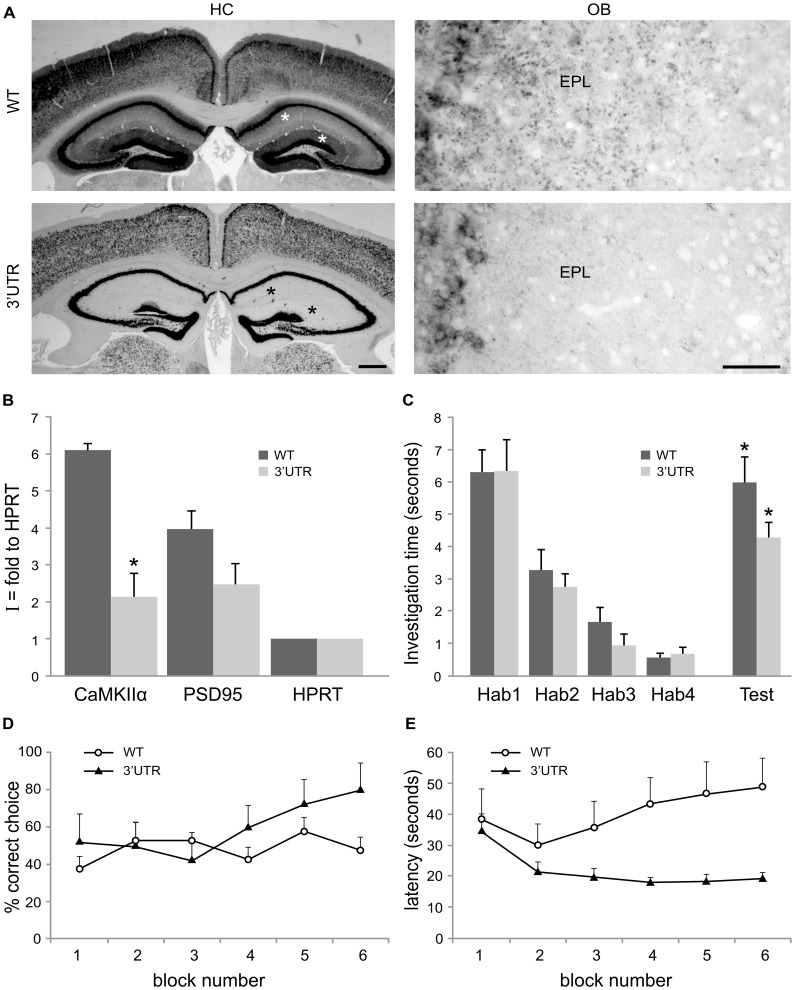
Altered CaMKIIα mRNA and protein synaptic localization disrupts olfactory associative learning.
A,
In situ hybridization for CaMKIIα mRNA in wild-type mice (WT, upper panels) and 3′UTR mutants (3′UTR, lower panels) shows a dramatic decrease of the dendritic staining (stars) in the mutant hippocampus (HC, left panels) and olfactory bulb (OB, right panels). EPL: external plexiform layer Scale bars: 200 µm and 50 µm, in HC and OB respectively. B, Quantification of the index of synaptic localization (I) of CaMKIIα and PSD95 mRNAs normalized to HPRT mRNA in WT and 3′UTR mutants. CaMKIIα mRNA index is significantly decreased in 3′UTR mutants as compared to WT (n = 3, p = 0.026) C, Behavioral habituation/dishabituation paradigm: both WT and 3′UTR mutants mice habituated to the habituation odor, as shown by decreased investigation time across the four trials (Hab1-Hab4) (WT: F(3,27) = 30.452, p<0.001; 3′UTR: F(3,27) = 20.469, p<0.001; ANOVA, trial effect) and discriminated. Upon presentation of the test odor (Test), the investigation time increased when compared to Hab4, indicating that the animals could discriminate the test odor from the habituation odor (WT: *p<0.00005; 3′UTR: *p<0.00005, t-test). D, Olfactory associative learning: mice were conditioned to associate an odor stimulus to a food reward. Success rate results are presented as the percentage of correct choice across consecutive blocks of trials (1 block = 4 trials). Conditioned WT mice learned the task as indicated by the increase in correct choice throughout blocks (F(5,49) = 3.391, p<0.01; ANOVA, block effect). In contrast, conditioned 3′UTR mutants did not show an increase in success rate across trials (F(5,54) = 1.078, p>0.1; ANOVA, block effect), showing that impaired CaMKIIα mRNA dendritic localization disrupts olfactory-associative learning. E, Latencies: conditioned WT mice showed a decrease in latency confirming that they learned the task (F(5,49) = 4.037, p<0.005; ANOVA, block effect). In contrast, latencies of conditioned 3′UTR mutants did not significantly change (F(5,54) = 0.635, p>0.5; ANOVA, block effect), indicating that the mutants were not able to associate odor and reward.